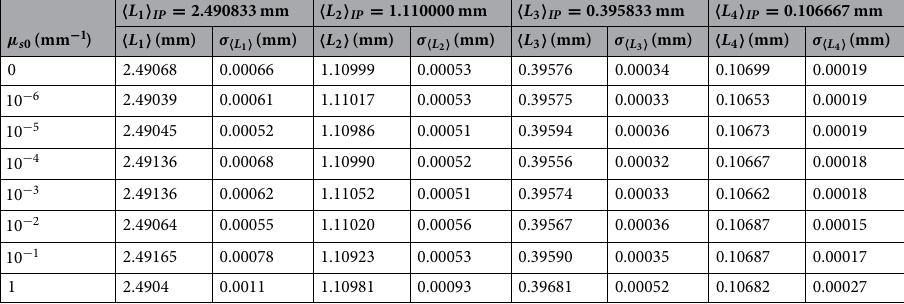
= L IP L L (cid:31) (cid:30) of each � MC −� � IP σ L � �